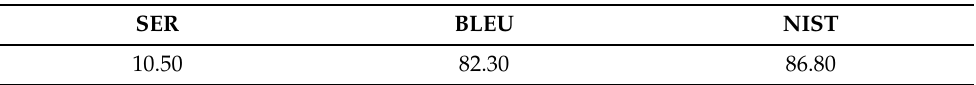
Table 8. Performance analysis of proposed translation system. SER: Sign Error Rate; BLEU: Bilingual Evaluation Understudy; MIST: National Institute of Standards and Technology.